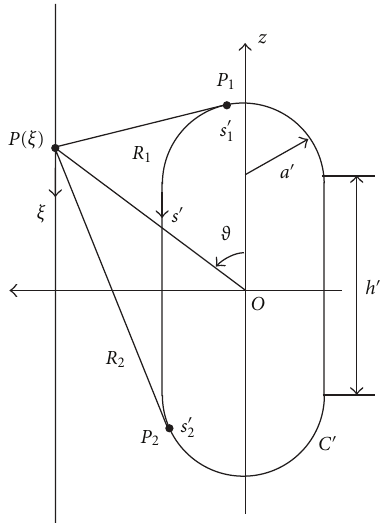
Figure 17: Relevant to a cylinder generatrix.